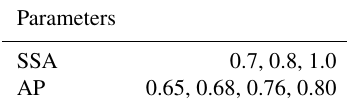
Table 3. List of SSA and AP values used for the sensitivity studies (for the standard retrievals, SSA = 0.9 and AP = 0.72 were